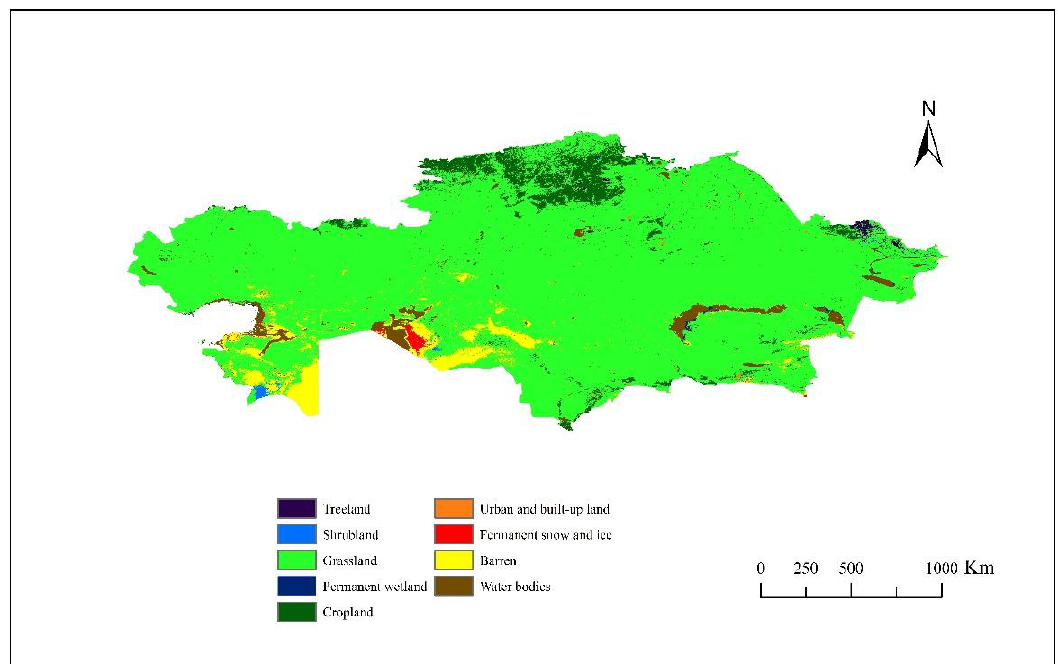
Figure 1. Land use in Kazakhstan in 2017.